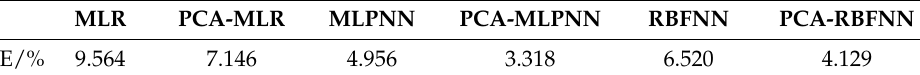
Figure 4. Principal component gravel map. Table 5. Comparison of model prediction results.